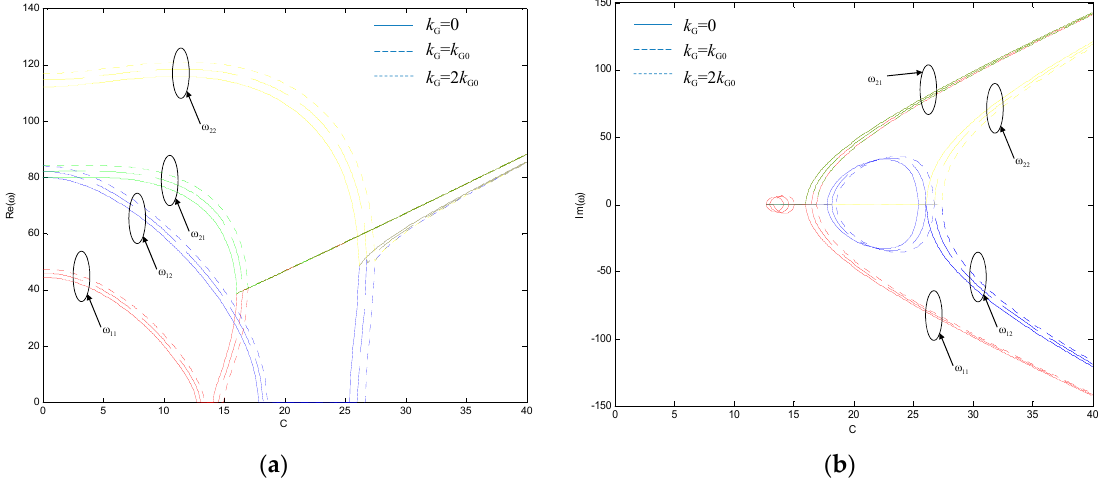
Figure 7. Effect of the Pasternak’s modulus k G on dimensionless complex frequencies of the axially-moving nanoplate. Appl. Sci. 2019 , 9 , x FOR PEER REVIEW